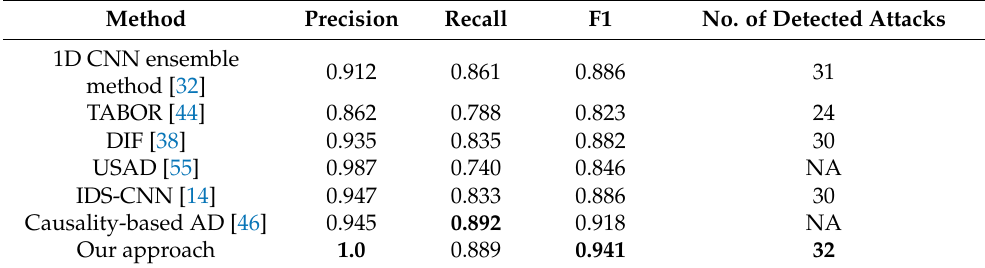
Table 5. Comparison of state-of-the-art attack detection techniques per event. NA signifies unavail- ability of the specific metric in the corresponding paper. Bold values denote the best performance in the correspnding